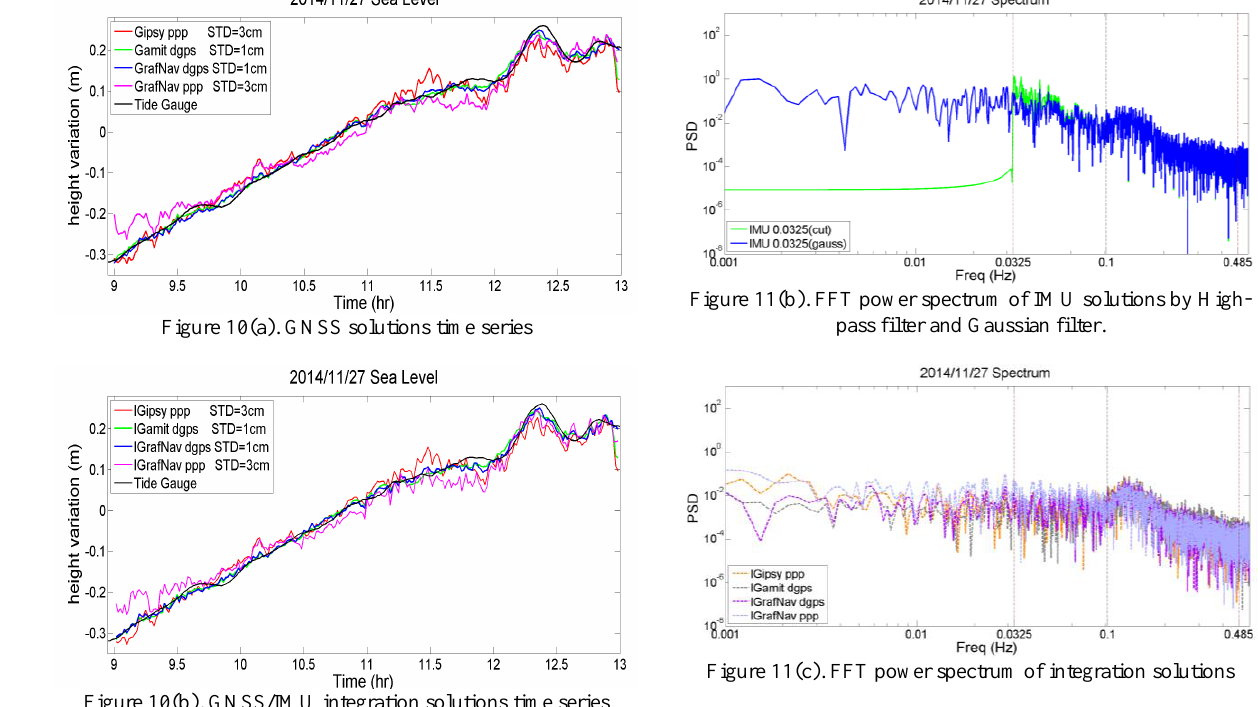
Figure 10(b). GNSS/IMU integration solutions time series